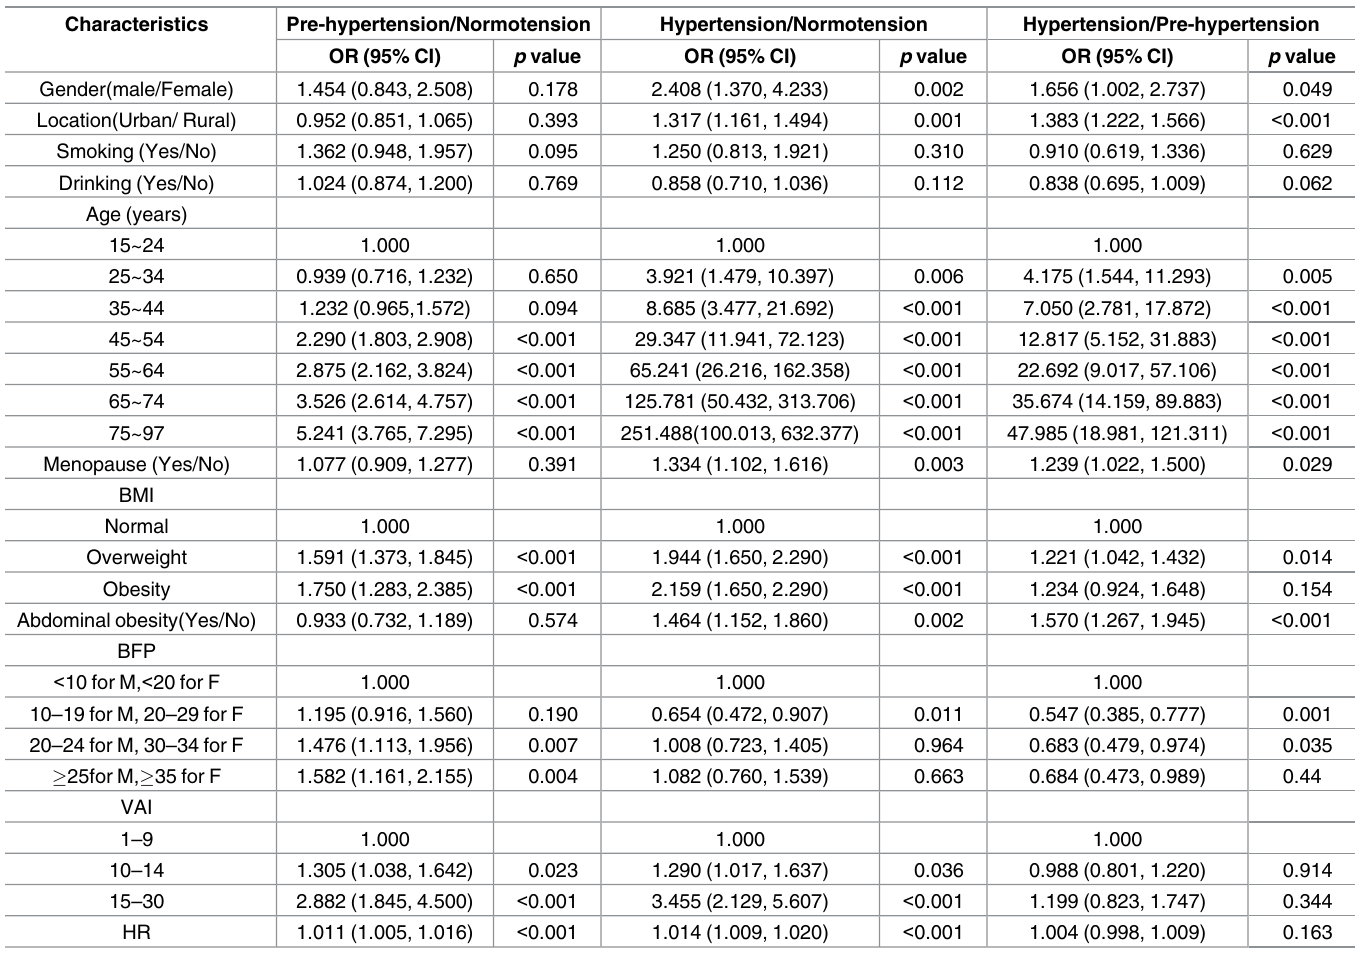
Table 6. Factors associated with Pre-hypertension and